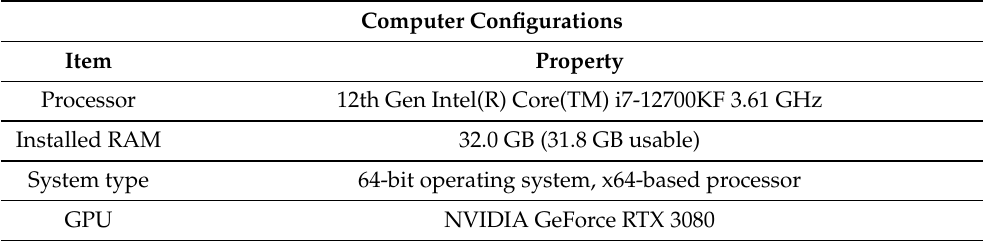
Table 1. Computer